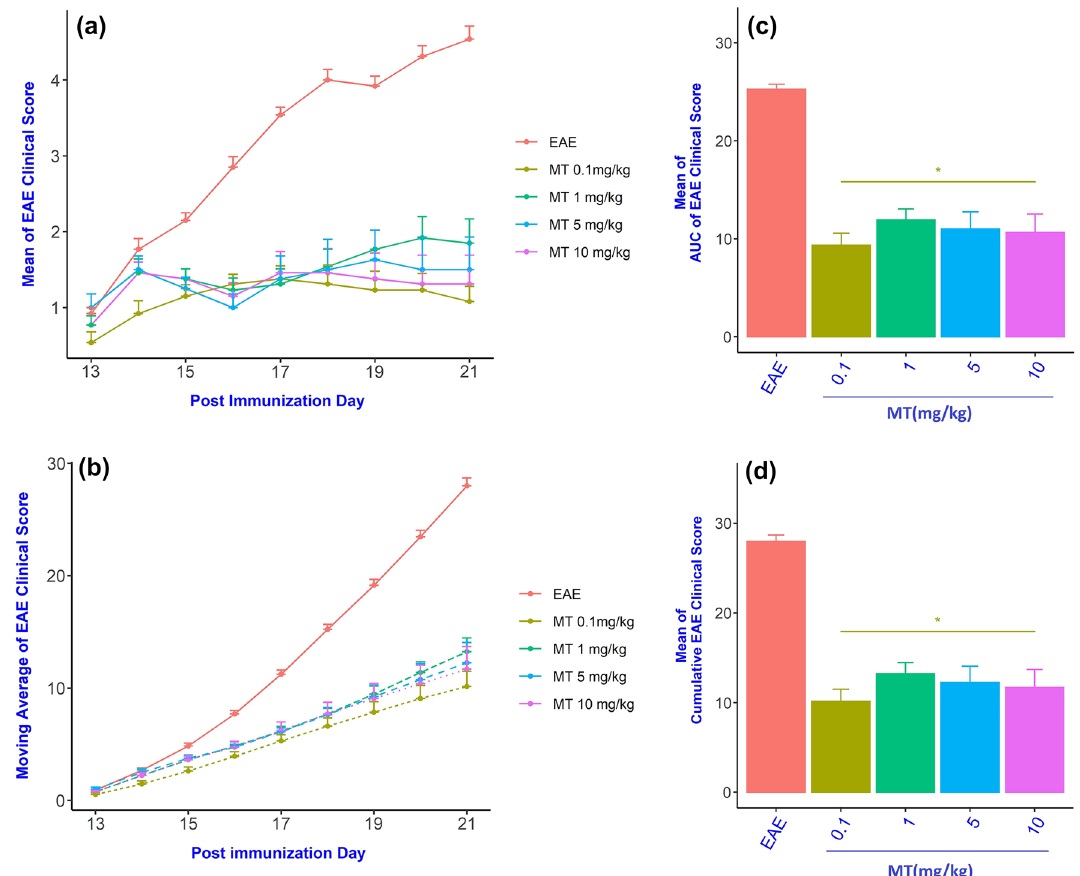
Figure 2. Amelioration of EAE in melatonin treated mice. Analysis of neurological disability displayed: ( a ) Dailly clinical score, ( b ) Moving average of the daily clinical score, ( c ) AUC of the daily clinical score and ( d ) Cumulative neurological disability, were significantly lower in melatonin compare to PBS treated EAE mice. Data are expressed as the Mean ± SEM (n = 8–13). Statistical analysis was performed by one-way analysis of variance (ANOVA) followed by the Tamhane test. Significance is indicated by * p < 0.0001 vs.